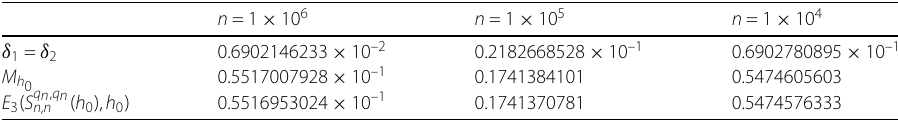
Table 3 The approximation error of S q n , q n n , n ( h 0 ) to h 0 by means of the Lipschitz functions on I R for θ = 0.1 × 10 –5